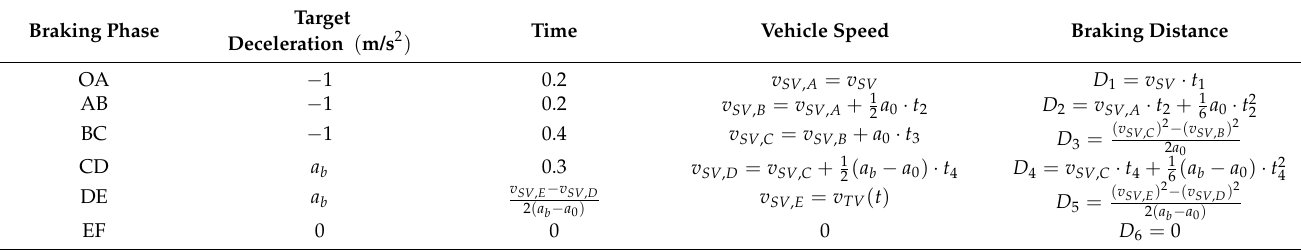
Figure 13. AEBS target deceleration and actual deceleration. Table 7. List of parameters for each braking phase.